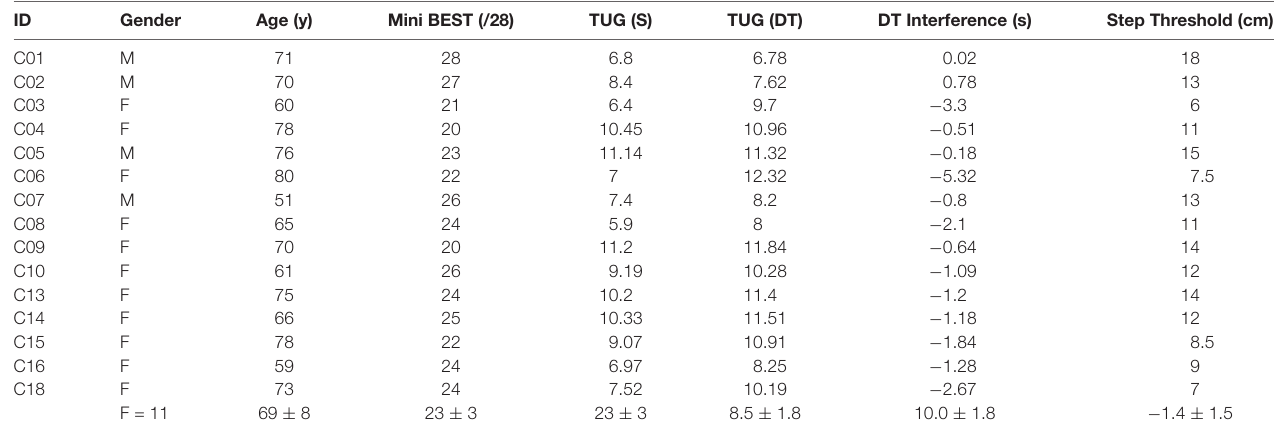
TABLE 1 | Participant